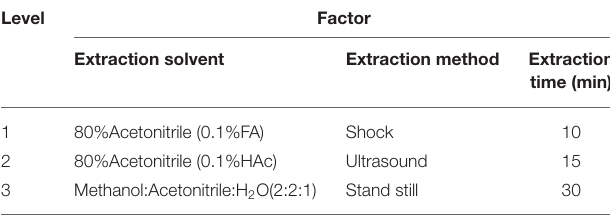
TABLE 1 | Factors for optimizing extraction method of sample